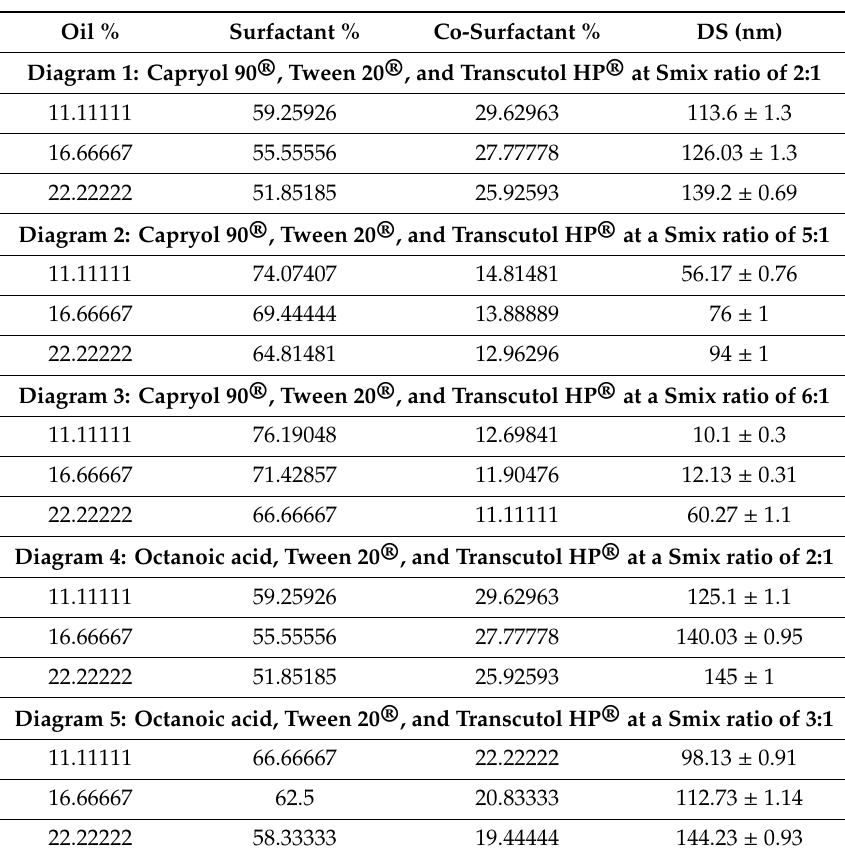
Figure 3. The pseudo-ternary diagram plots for the L-SEDDs formulations. ( A ) For the L-SEDDs formulation composed of Capryol 90 ® (oil), Tween 20 ® (surfactant), and Transcutol HP ® (co-surfactant) at di ff erent Smix ratios. ( B ) For the L-SEDDs formulations composed of Octanoic acid (oil), Tween 20 ® (surfactant), and Transcutol HP ® (co-surfactant) at di ff erent Smix ratios. Table 3. The selected L-SEDDs components’ concentrations and droplet size (DS) out of the constructed pseudo-ternary diagrams. Mean ± SD, n =